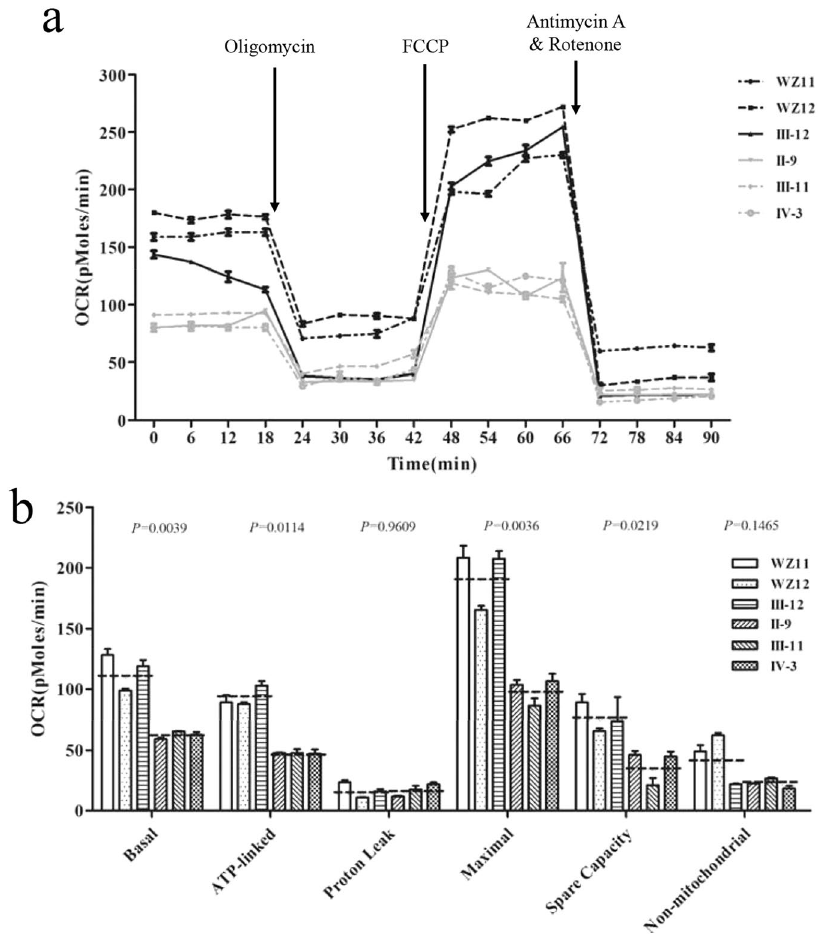
Figure 4. OPA1 mutation impaired mitochondrial bioenergetics. ( a ) An analysis of O 2 consumption in the various cell lines using different inhibitors. The rates of O 2 (OCR) were first measured on 2 × 10 4 cells of each cell line under basal condition and then sequentially added to oligomycin (1 μ M), carbonyl cyanide p-(trifluoromethoxy) phenylhydrazone (FCCP) (0.5 μ M), rotenone (1 μ M) and antimycin A (1 μ M) at indicated times to determine different parameters of mitochondrial functions. ( b ) Graphs presented the basal OCR, ATP-linked OCR, proton leak OCR, maximal OCR, reserve capacity OCR and non-mitochondrial OCR in mutant and control cell lines. Non-mitochondrial OCR was determined as the OCR after rotenone/antimycin A treatment. Basal OCR was determined as OCR before oligomycin minus OCR after rotenone/antimycin A. ATP-linked OCR was determined as OCR before oligomycin minus OCR after oligomycin. Proton leak was determined as basal OCR minus ATP-linked OCR. Maximal was determined as the OCR after FCCP minus non-mitochondrial OCR. Reserve capacity was defined as the difference between maximal OCR after FCCP minus basal OCR. The average of four determinations for each cell line is shown, the horizontal dashed lines represent the average value for each group. Graph details and symbols are explained in the legend to Fig.